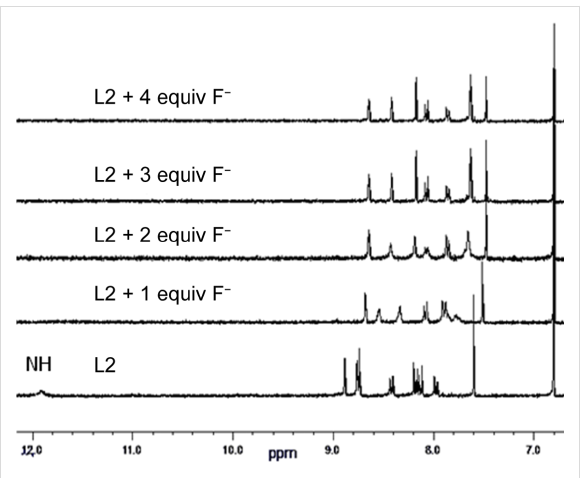
Figure 8: 1 H NMR spectra of ligand L2 (4·10 − 3 M in DMSO- d 6 ) upon addition of successive aliquots of TBAF (DMSO- d 6